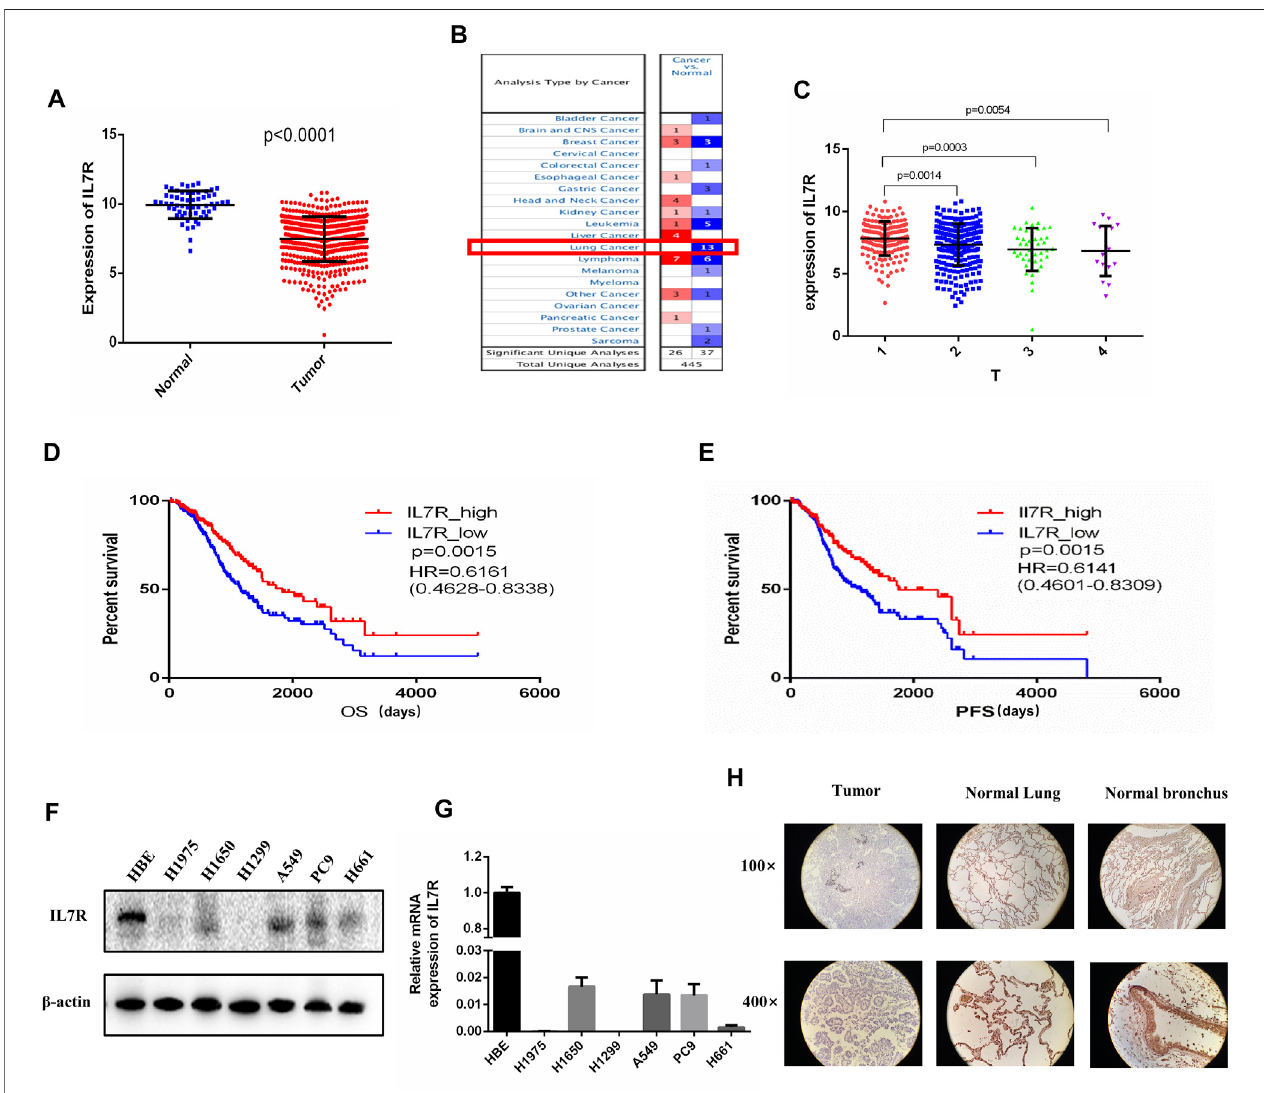
FIGURE 5 | The expression of IL7R in lung adenocarcinoma tissues was lower than that in normal tissues and correlated with tumor size and patient survival. (A) IL7R expression in lung adenocarcinoma tissue was signi fi cantly lower than that in normal lung tissue based on TCGA data, p < 0.001. (B) The Oncomine database showed that the expression level of IL7R in lung cancer tissues in 13 data sets was lower than that in normal tissues. (C) The expression level of IL7R was negatively correlated with tumor size. (D) Kaplan-Meier survival curves showed the LUAD patients with high IL7R expression had better overall survival than those with low IL7R expression, p = 0.0015. (E) Patients with high IL7R expression also had better progression-free survival than those with low IL7R expression, p = 0.0015. (F) The expression of IL7R in normal lung epithelial cell line HBE was higher than that in lung adenocarcinoma cell lines assayed by Western blot and (G) qRT-PCR. (H) Immunohistochemical staining showed IL7R was expressed at low level in LUAD tumors (left) compared with para-carcinoma tissue (lung tissue, middle; bronchus, right), (×100 and×400, respectively).